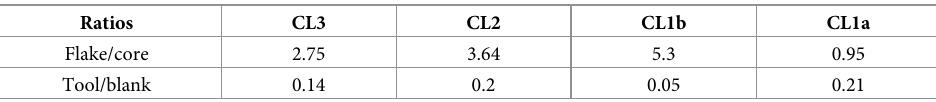
Table 9. Ratios of flakes per core and tools per